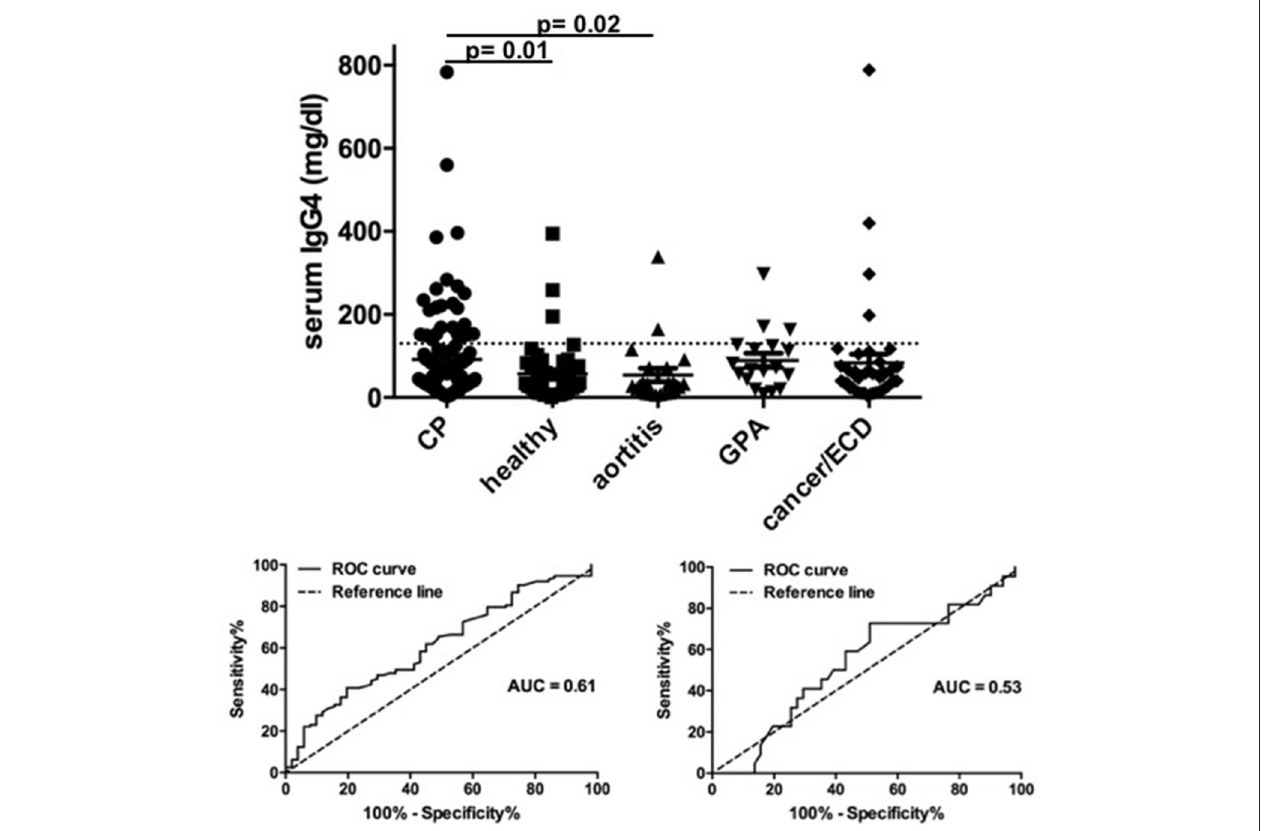
FIGURE 1 | Serum IgG4 levels in chronic periaortitis patients and controls. In the upper figure, the plot shows serum IgG4 levels in patients with active chronic periaortitis, healthy controls, patients with aortitis (secondary to Takayasu arteritis or giant-cell arteritis), granulomatosis with polyangiitis (GPA, Wegener’s) and retroperitoneal malignancies or Erdheim-Chester disease (ECD). The horizontal line indicates the upper limit of normal of serum IgG4 (135 mg/dL). In the lower figures, the receiver operating characteristic (ROC) curves show the sensitivity and specificity of serum IgG4 in discriminating chronic periaortitis patients from healthy controls (left) and aortitis patients (right)